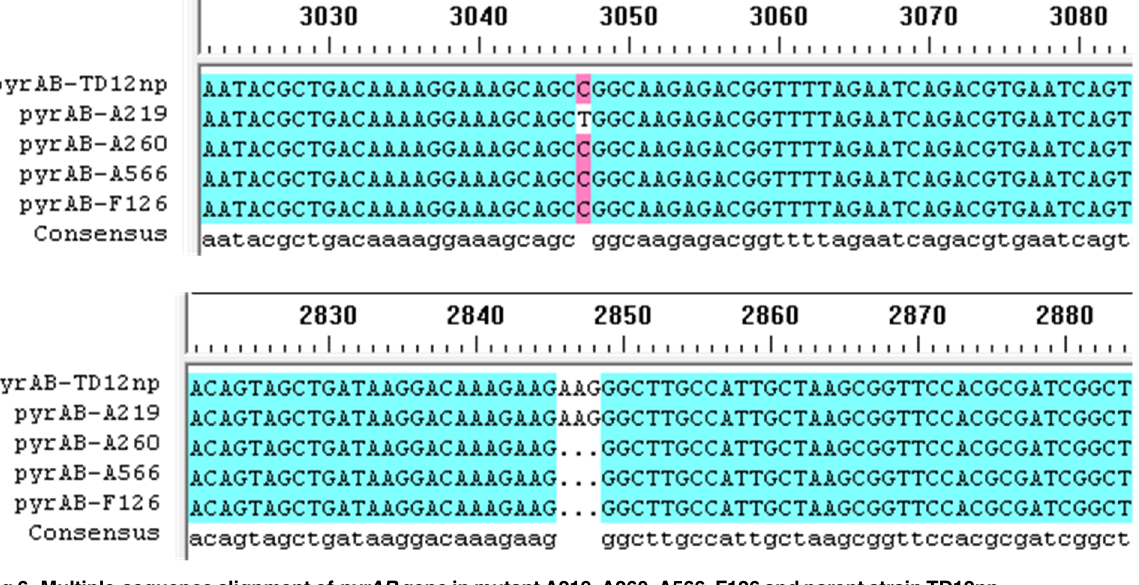
Fig 6. Multiple-sequence alignment of pyrAB gene in mutant A219, A260, A566, F126 and parent strain